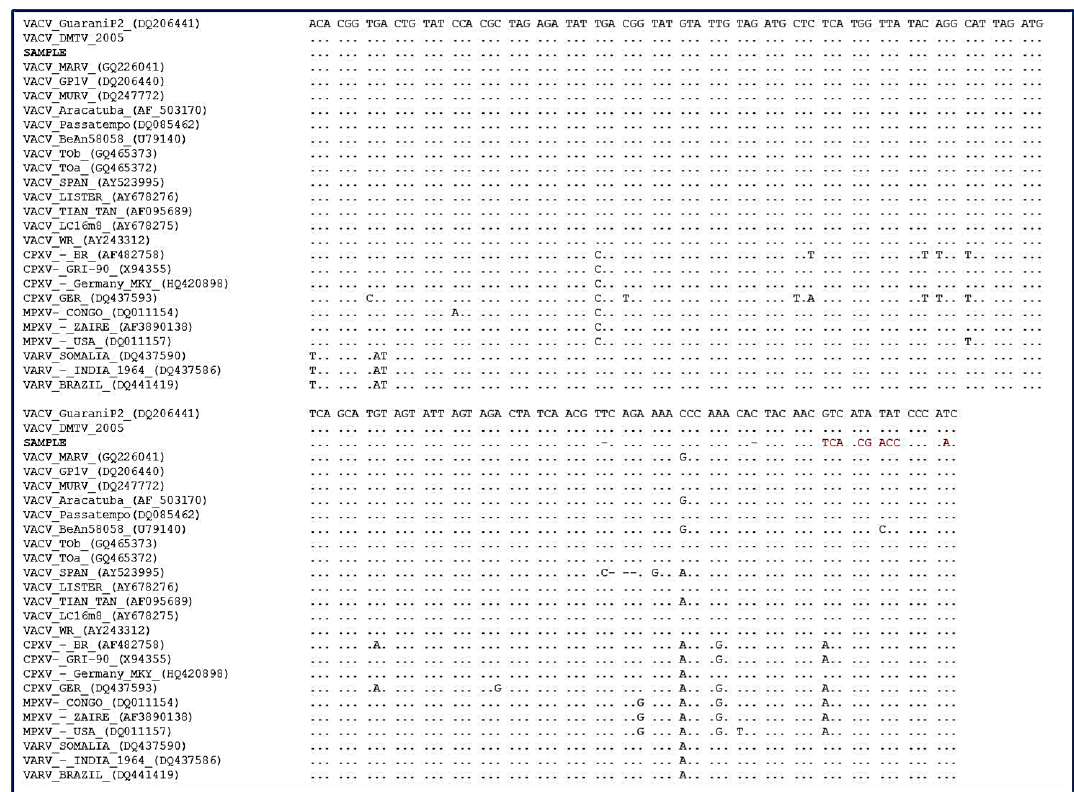
Figure 2. Phylogenetic tree based on the OPV nucleotide sequence of the vgf gene showing the rodent strain (sample) cluster. In bold, the out group shope fibroma virus (SFV).